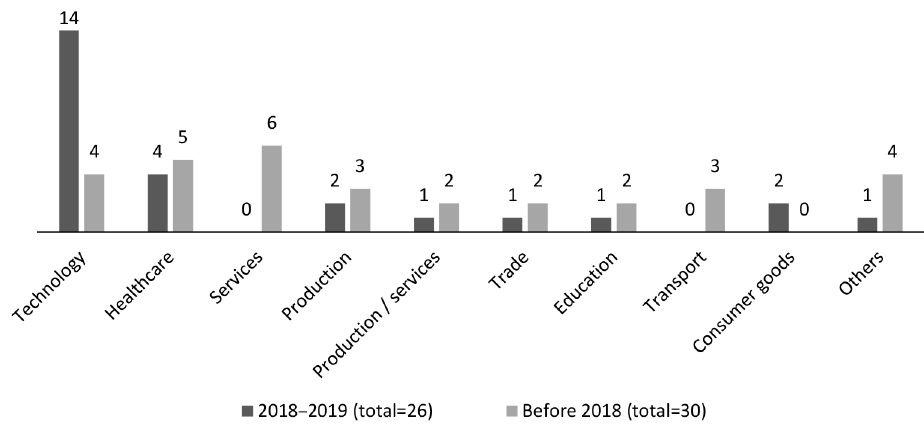
Figure 4. Main industries in which search funds invested outside the USA and